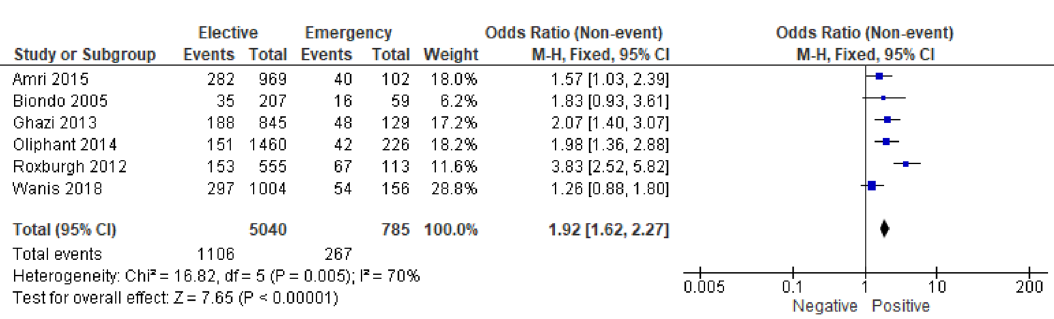
Figure 9. Association between presence of vascular invasion and emergency presentation—Forest Plot.